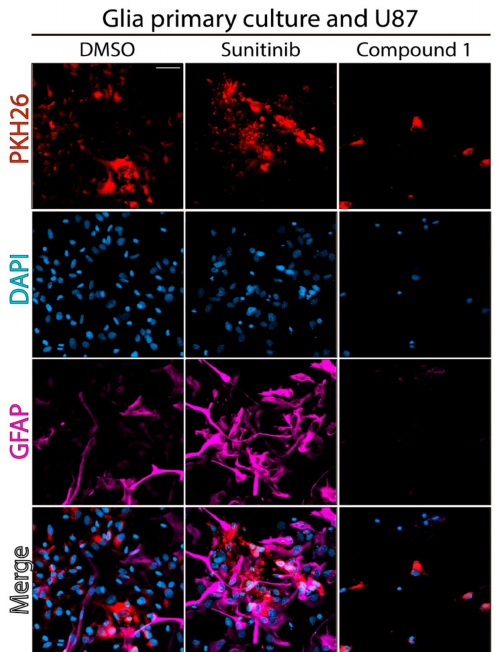
Figure 4. E ff ect of compound 1 on co-cultures of astrocytes with U87 MG tumor cells. Confocal images showing the co-culture of U87 MG cells (PKH26) and mouse neonatal reactive astrocytes (GFAP). The nucleuses were stained with DAPI. Co-cultured cells were treated at IC 50,U87 MG doses of Sun or compound 1 or with DMSO as a control, for 24 h. Scale bar: 20 µ